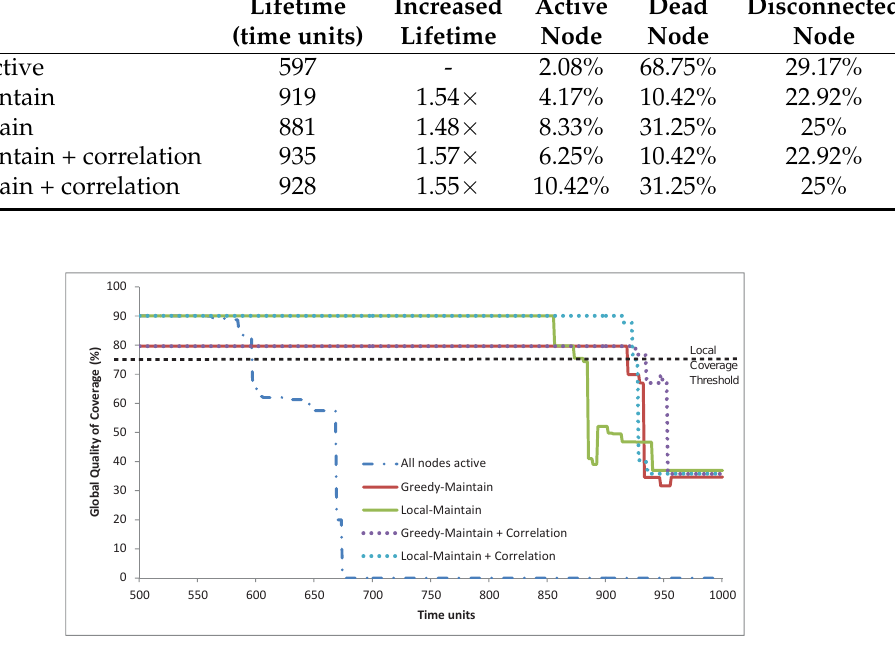
Figure 12. CIT-1’s global quality of coverage.